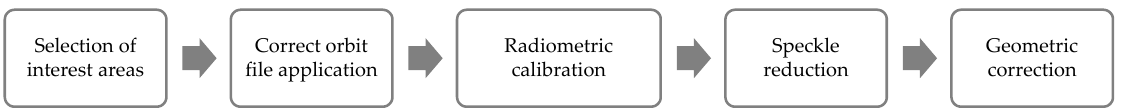
Figure 4. Flowchart showing the preprocessing chain used in RADAR SAR Sentinel-1 images.